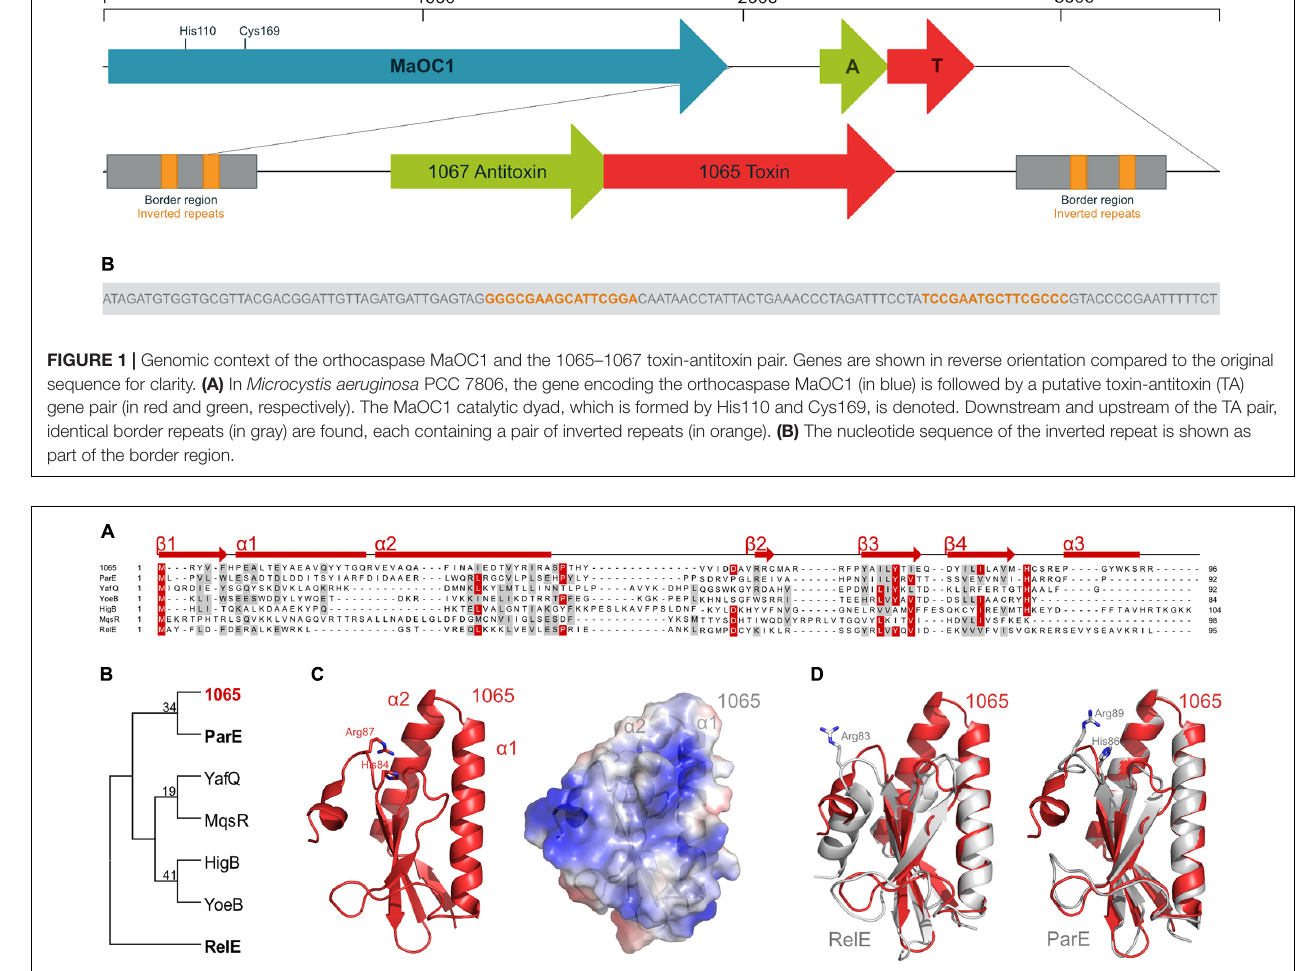
FIGURE 2 | Classification of the 1065 toxin. (A) Sequence alignment of the 1065 toxin with representatives of other RelE/ParE toxins (NCBI IDs: ParE, NP_310308; YafQ, NP_414760; YoeB, NP_707909; HigB, NP_311992; MqsR, NP_417494; RelE, NP_416081). Identical residues are colored red and similar amino acids are shaded gray with a threshold of 50% for coloration. Predicted secondary structures of the 1065 toxin are shown above the alignment. The sequence alignment was performed with PROMALS and the image was generated with BioEdit. (B) The unrooted phylogenetic tree of selected toxin representatives. The tree was constructed using the Neighbor-Joining method of the MEGA software (version 6) and is based on the alignment shown in panel A. The 1065 toxin is shown in red, while ParE and RelE toxins, whose structures are shown in panel D, are shown in bold. (C) Homology model of the 1065 toxin in cartoon representation (left) and its surface potential (right; where red shows the acidic surface potential and blue shows the basic surface potential). The models were predicted by I- TASSER software. (D) Overlay of the 1065 toxin model (shown in red) and the RelE (PDB: 4FXE) (left) or ParE (PDB: 5CW7) toxins (shown in gray) (right). Basic amino acid residues known to be responsible for toxic activity are shown as sticks. All images were generated with PyMOL (DeLano